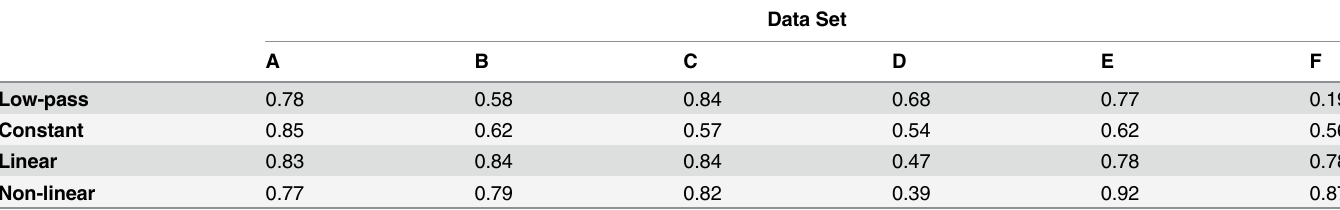
Table 6. Area under the ROC-curve for the different methods and data sets.